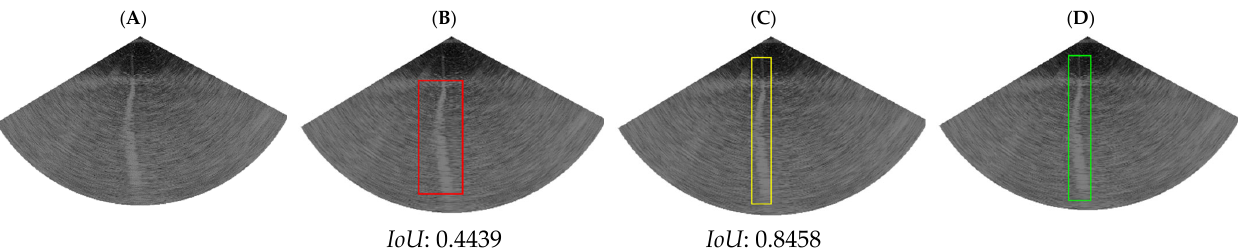
Figure 16. Comparison between our detection method and histogram-similarity detection method. The red, yellow, and green rectangles are the detection boxes of the histogram similarity method, our method, and ground truth, respectively. IoU values were calculated using Equation (13). ( A ): Raw Water Column Image; ( B ): Detection Result using Histogram Similarity; ( C ): Our Detection Result; ( D ): Manual Ground Truth.